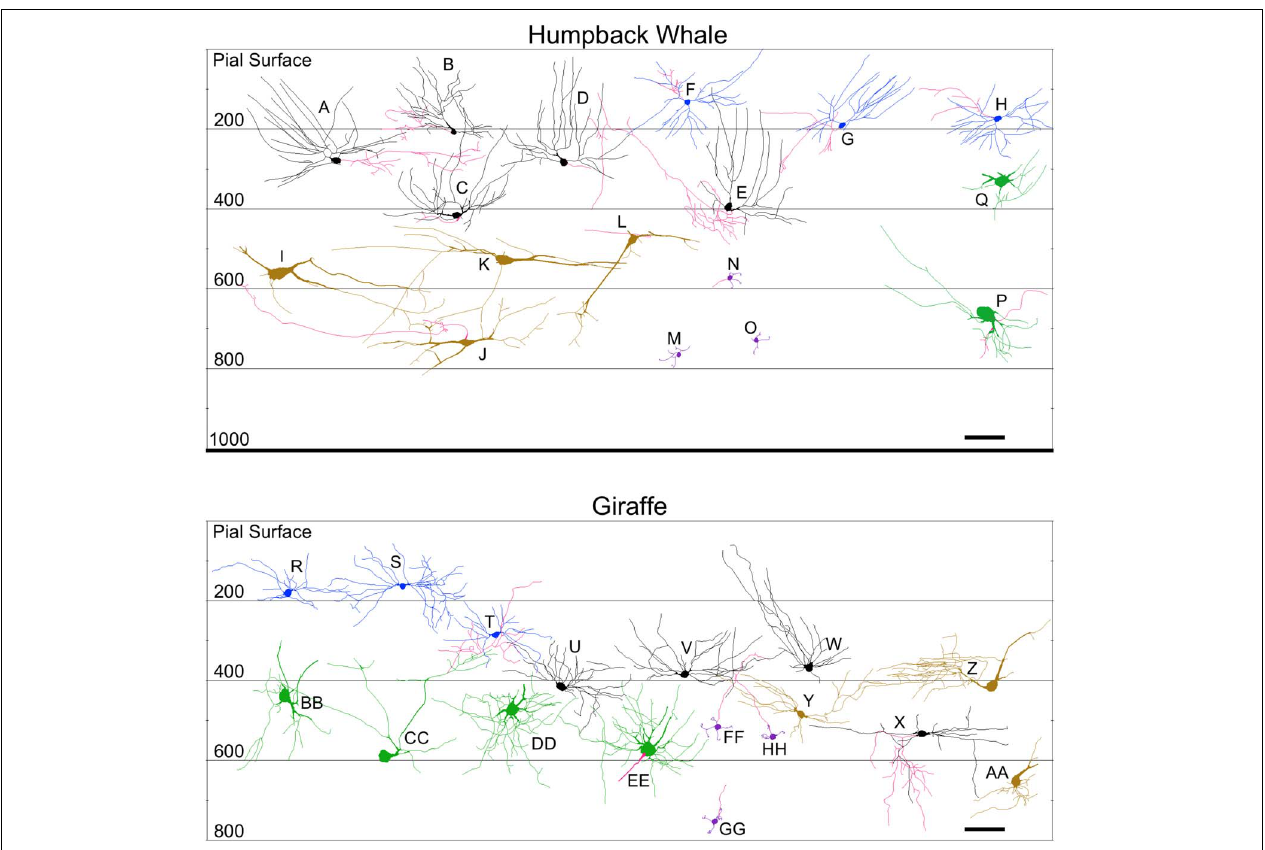
FIGURE 10 | Neurolucida tracings of neurons in the cerebellar cortex of the humpback whale (top) and giraffe (bottom) indicating relative soma depth from the pial surface (in µ m). Basket neurons (A–E ; U–X) ; stellate